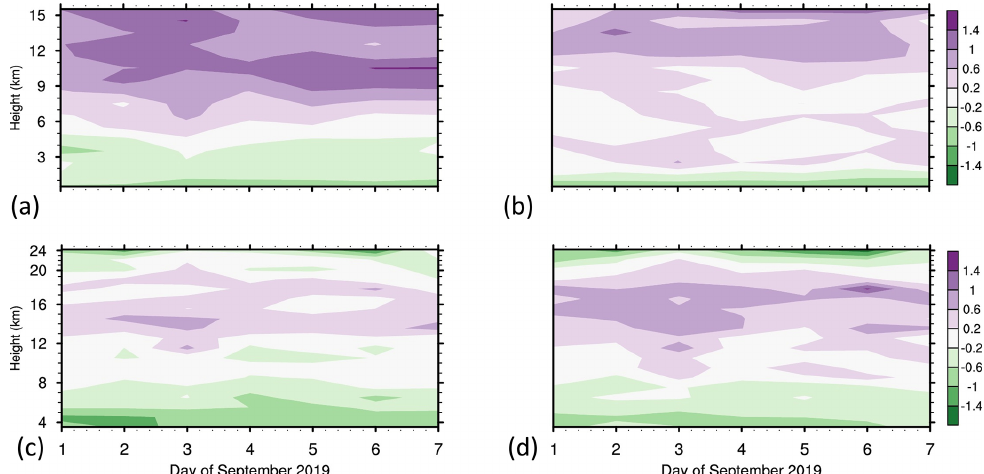
Figure 2. Vertical and daily variations in global horizontal biases (ms − 1 ) for Mie winds (a, b) and Rayleigh winds (c, d) in ascending (a, c) and descending (b, d) orbits.